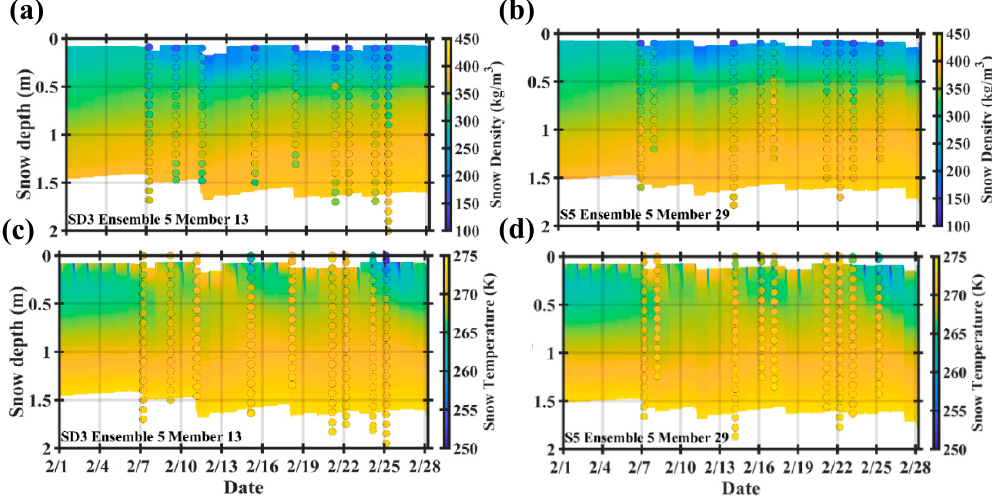
Figure 6. Evaluation of predicted snow density ( a , b ) and temperature ( c , d ) profiles against measured snowpit profiles (circles). Left column: Ensemble 5 Member 13 (HRRR grid point closest to the SD3 ECMWF grid center, Figure S1a). Right column: Ensemble 5 Member 29 (HRRR grid point closest to the center of the S5 ECMWF grid, Figure S1a). The measured values are graphed at the measurement depth in the SnowEx’ 17 records. The model values are graphed at the mid-point of each layer. Time-series of simulated snowpack stratigraphy (number of layers and layer thickness) are available in Supplementary Information (Figure S7b,c).